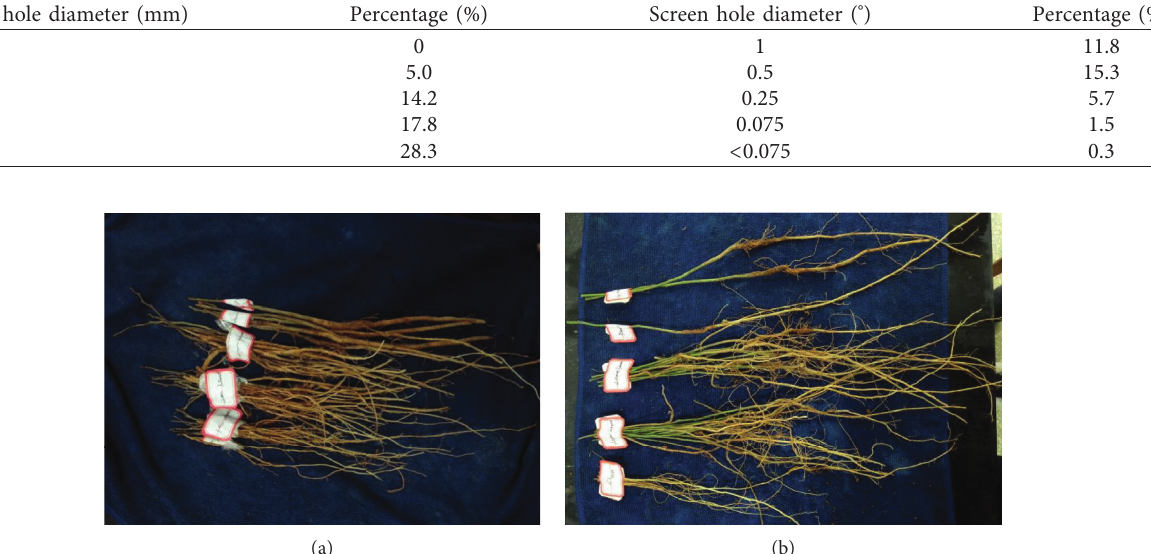
Figure 3: Morphological characteristics of different root systems: (a) root system with a length of about 20 mm; (b) root system with a length of about 28.8